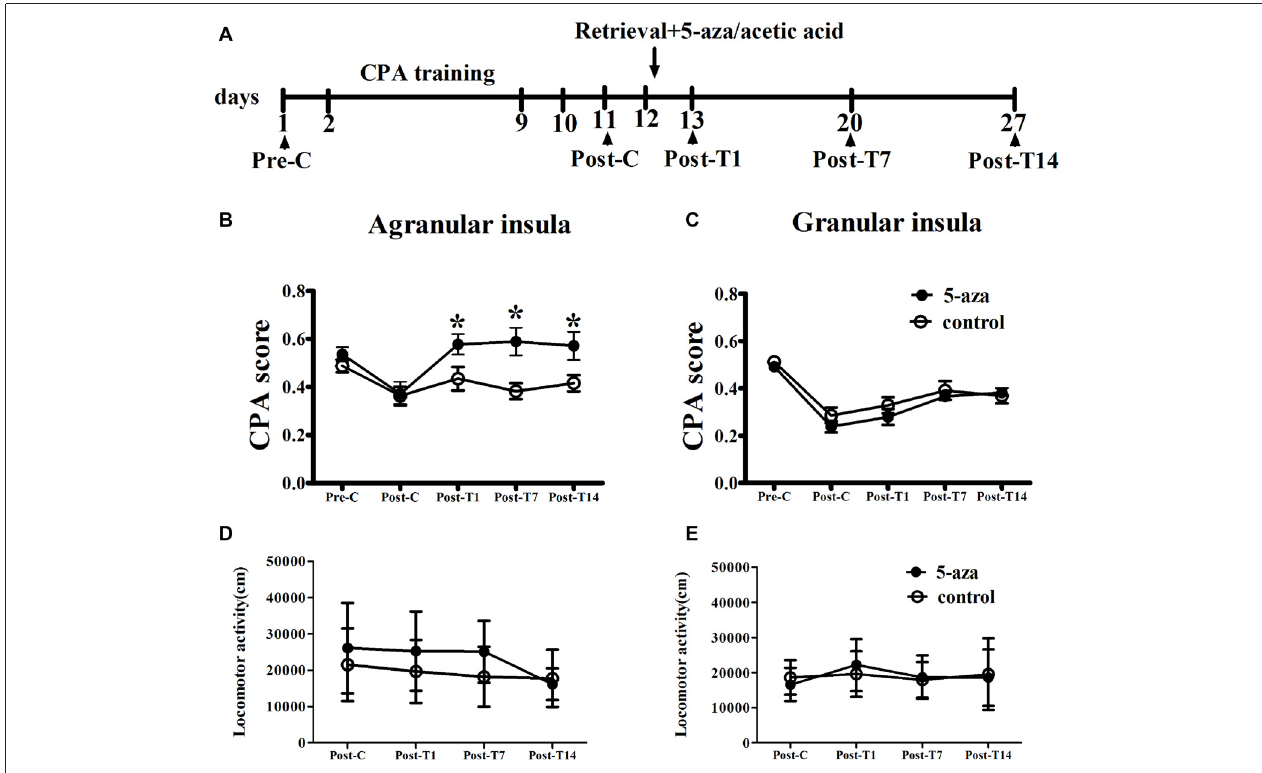
FIGURE 2 | Effects of microinjection of 5-aza-2 (cid:48) -deoxycytidine (5-aza) into AI and GI on the reconsolidation of conditioned place aversion (CPA). (A) Timeline of experimental procedure (B) 5-aza injection into AI blocked the reconsolidation of CPA. (C) Injection of 5-aza into GI did not disrupt the reconsolidation of CPA. (D,E) The locomotor activity of all groups in experiment 1. Data are presented as mean ± SEM. ∗ p < 0.05, compared to control at the same time point.